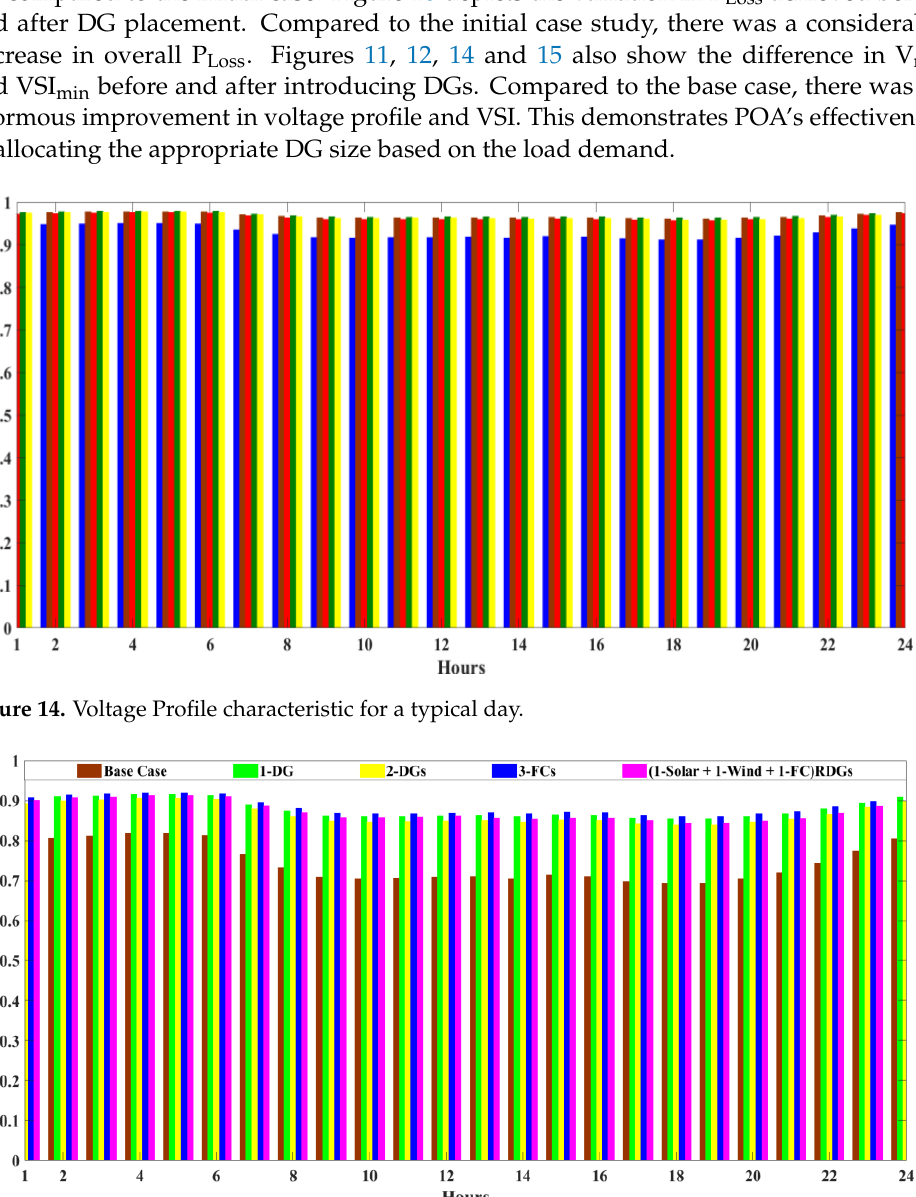
Figure 15. Voltage stability Index characteristic for a typical day.